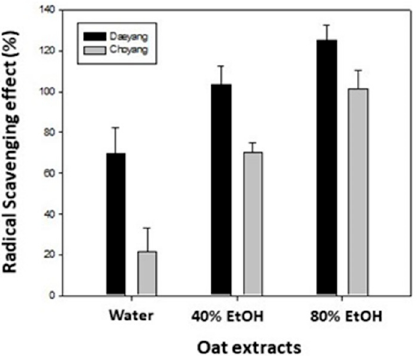
Figure 1. Antioxidant activities of oat extracts. In vitro 2,2-Diphenyl-1-picryl-hydrazyl-hydrate (DPPH) free radical scavenging activities of Daeyang and Choyang oat extracts at concentration of 5 mg/mL. Data are expressed as mean ± SD.